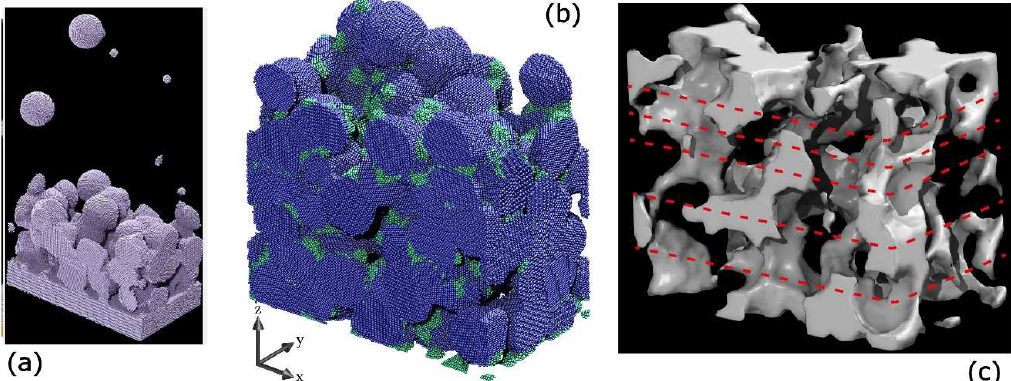
Figure 6. ( a ) MD simulation snapshot of the landing process employed to build the virtual film. ( b ) Rendering of the final virtual NP thin film. The Ag atoms composing big (set B) and small (set S) NPs are colored in blue and green, respectively, following the same color definitions as in Figure 3b. The average film thickness is 28.6 nm. ( c ) Void structure. The white 3D scaffold represents the voids between the deposited NPs. The cell base size for all panels is 35 × 20 nm 2 . Panels ( b , c ) are adapted from ref. [25], further permission related to the material excerpted should be directed to the ACS.